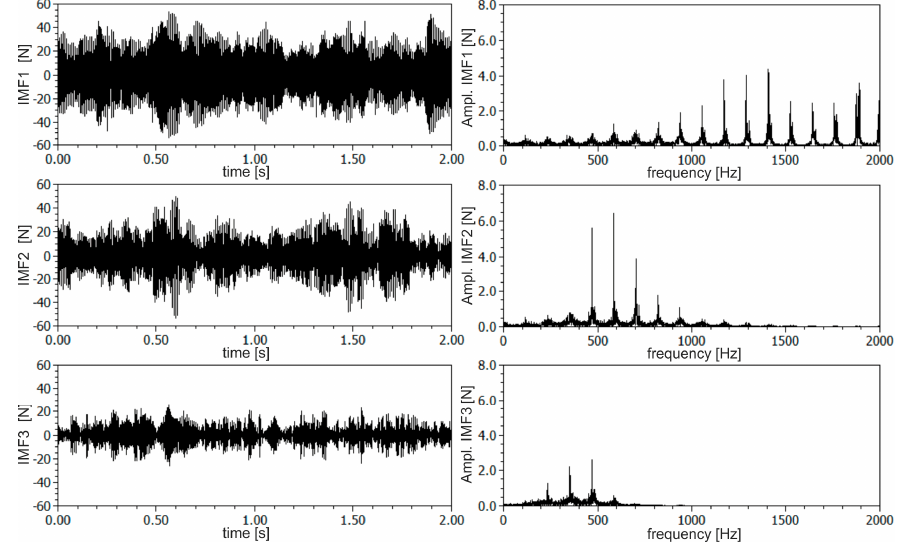
Figure 7. The first three components and their amplitude spectra extracted from the resultant force F xy for unstable machining (based on the theoretical SLD), a p = 0.5 mm, n = 7000 rpm.